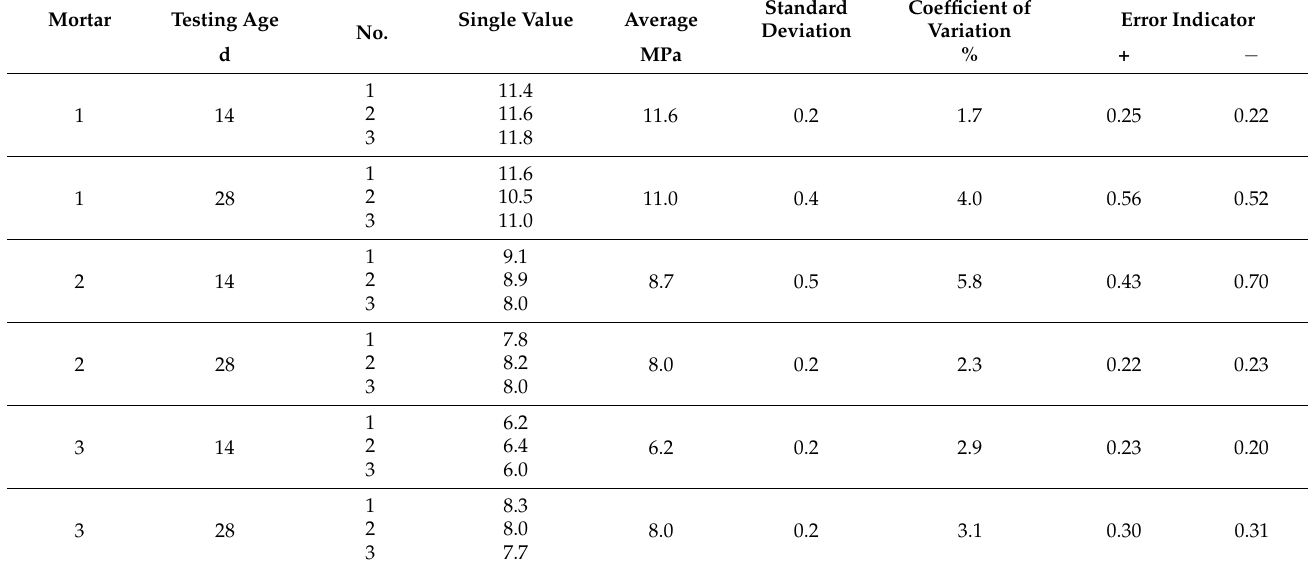
Table A2. Flexural bending strength up to 28 days, Mortar 1–3.